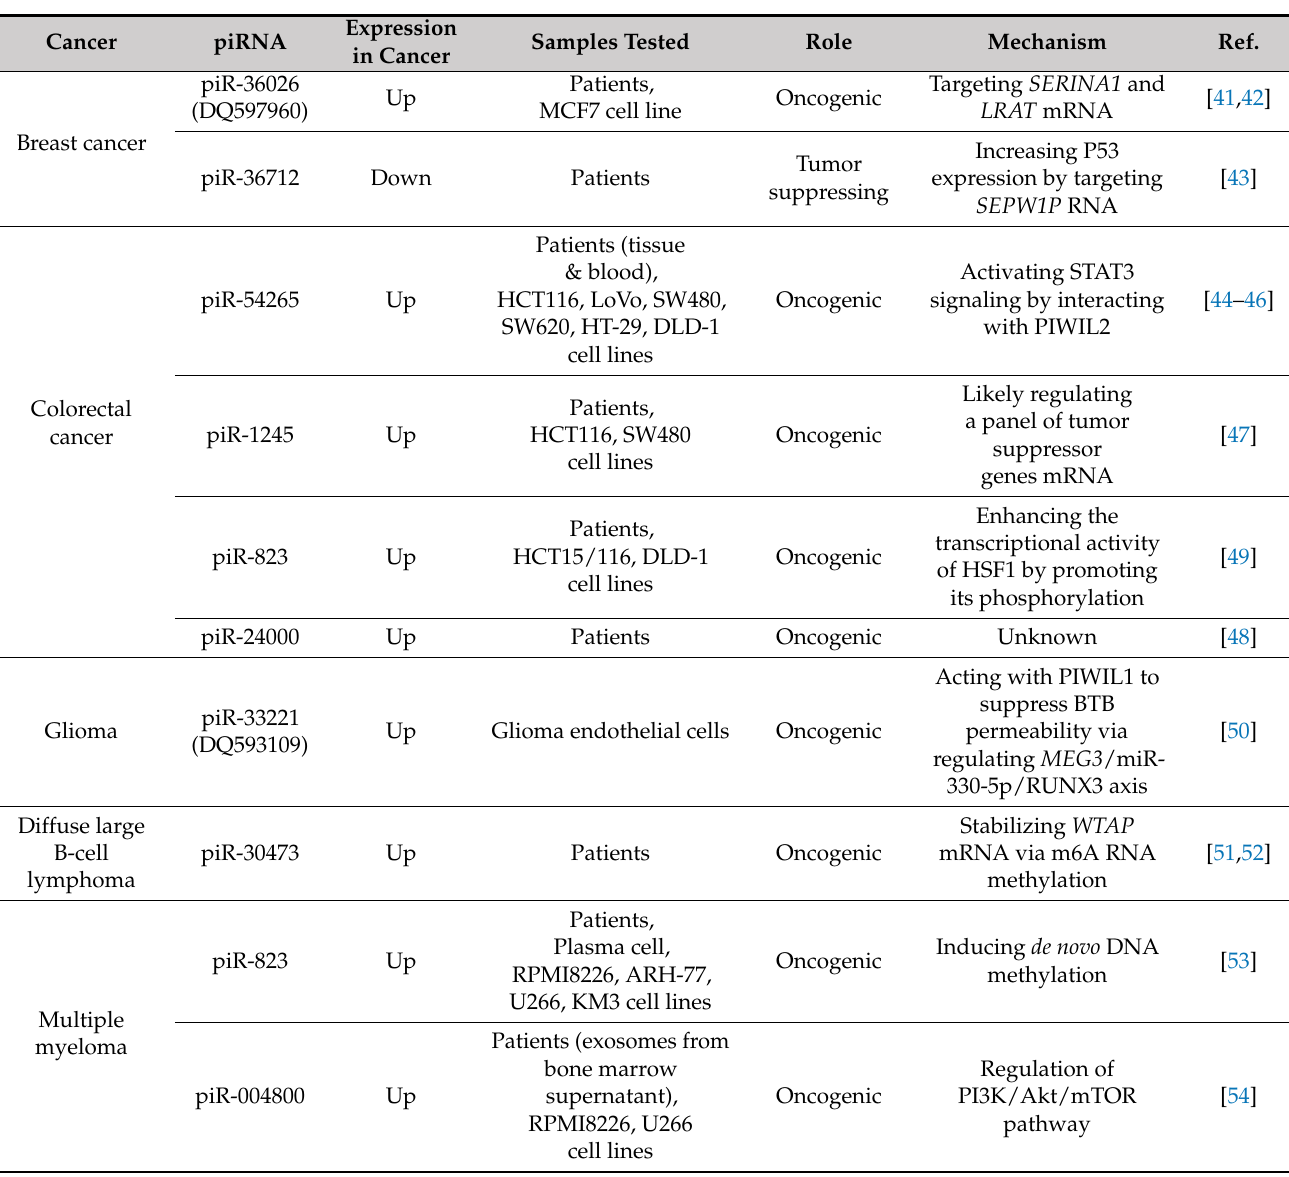
Table A2. Oncogenic piRNA and tumor-suppressor